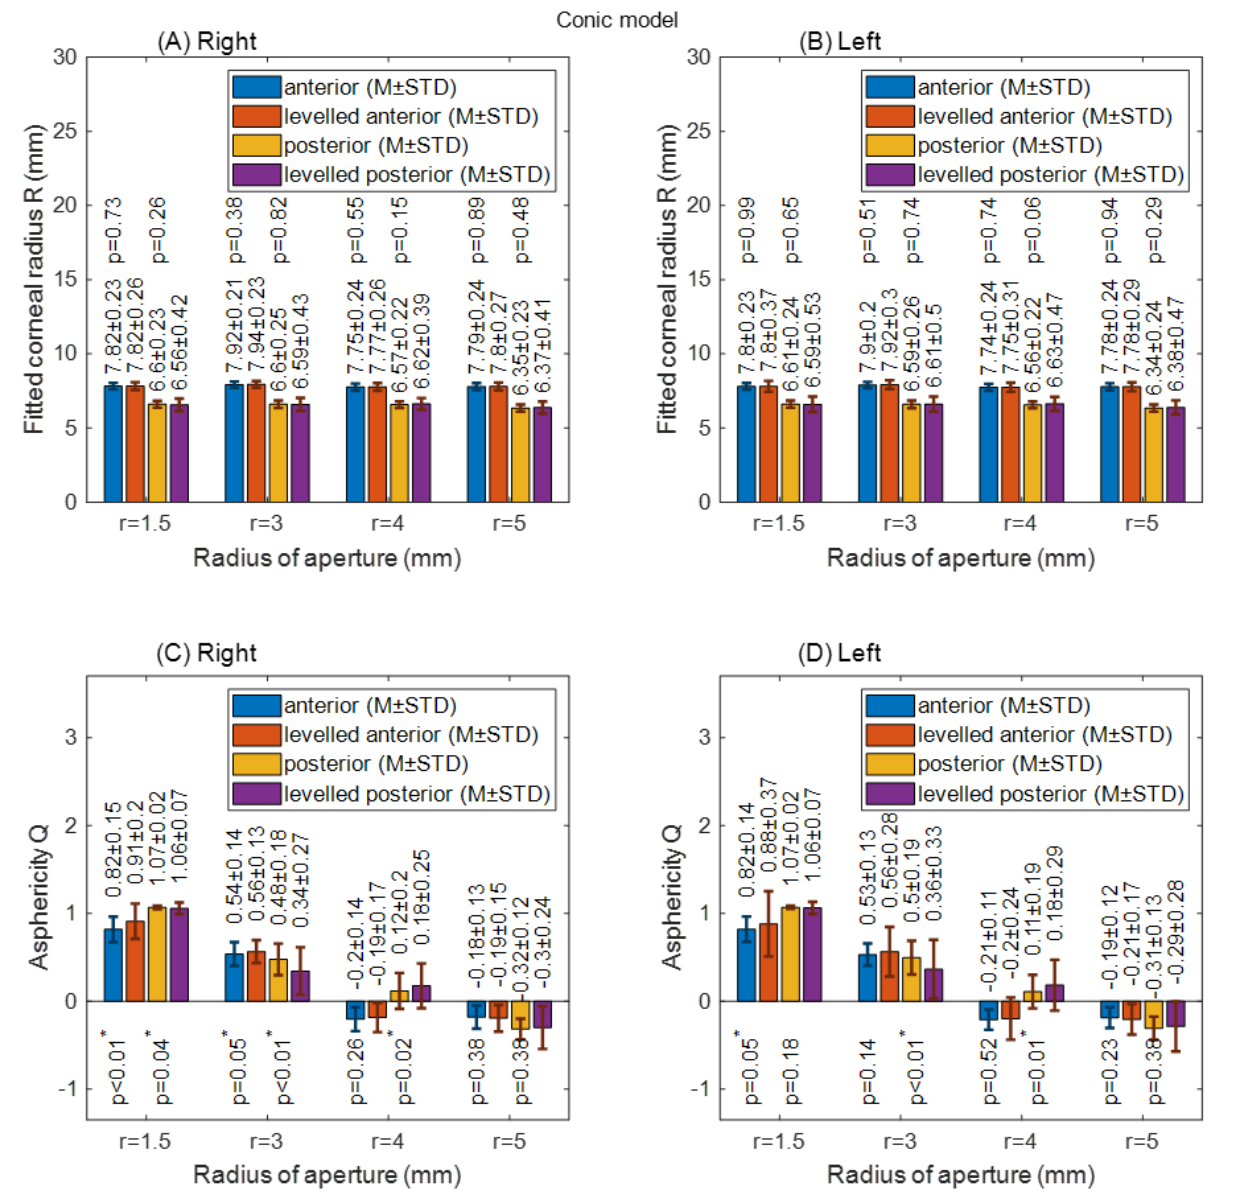
Figure 6. Corneal apical radius (R) and asphericity (Q) fitted to conic model with different radii of aperture (r). ( A ) Right corneal fitted radii; ( B ) Left corneal fitted radii; ( C ) Right corneal asphericities; ( D ) Left corneal asphericities.